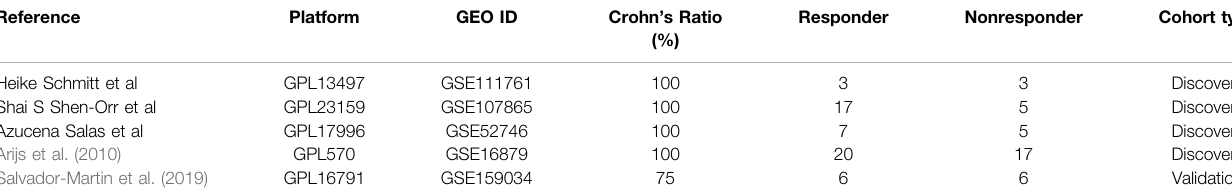
TABLE 1 | Detailed information of included cohorts in the combining analysis.